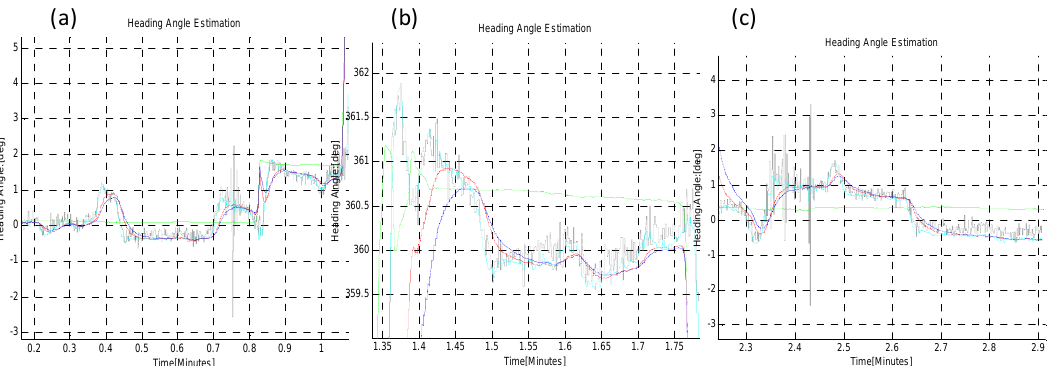
Figure 18. Zoom-in view of continuous Turn-in-place test (B-iii): Start ( a ); mid ( b ) and at the end ( c ) of rotation in CW and CW through 0~360° rotation. The q ‐ Method heading estimate is noisy and has large errors due to the dynamic condition of the sensor.